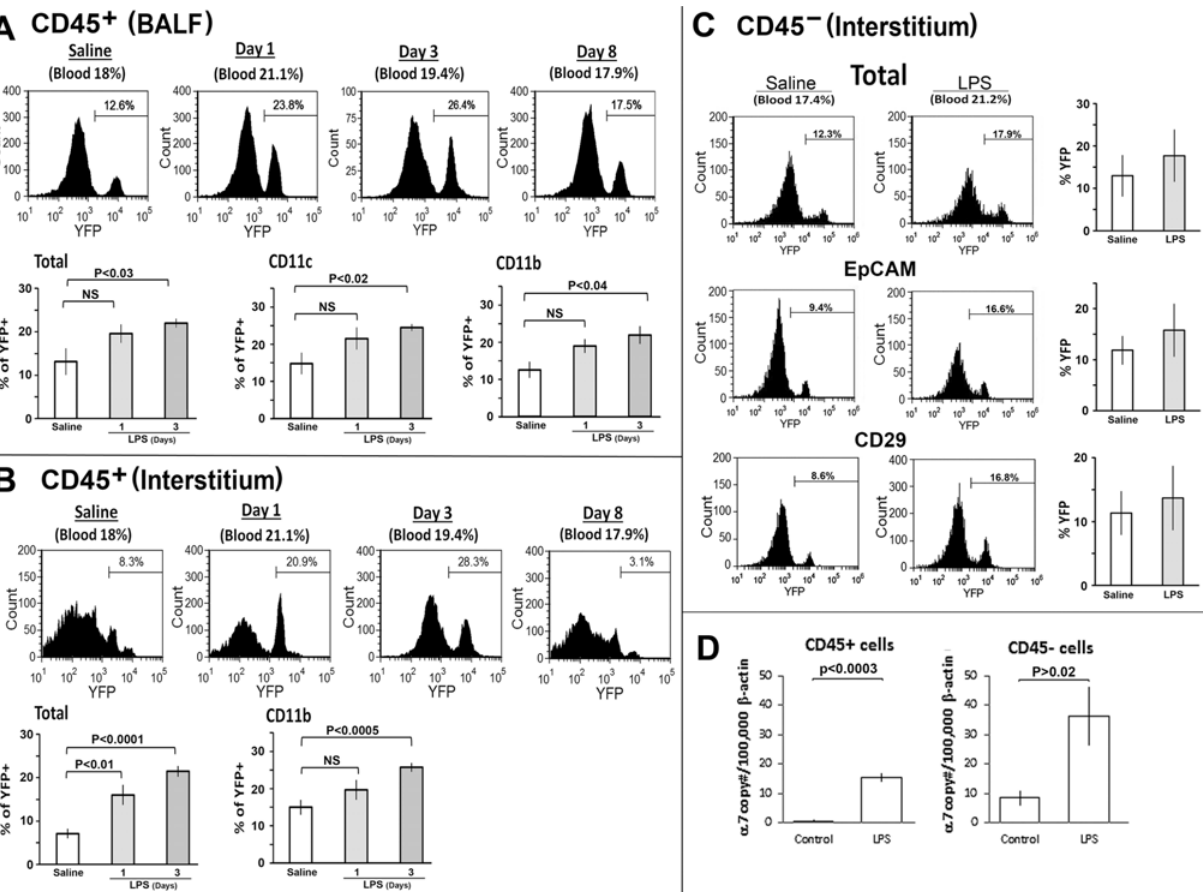
Fig 2. Phenotypic characteristics of BALF and interstitial cells from α 7 Cre:YFP mice challenged with i.n. LPS. Mice expressing cells that are lineage marked for WT α 7 expression ( α 7 Cre:YFP , 3 – 5 mo, 3 – 5 mice per group) were challenged with i.n. LPS (250 μ g/mouse in 30 μ l of saline). Control mice received i.n. 30 μ l of saline. With LPS administration i.n., the number of cells isolated from the BALF and interstitium (CD45 + ) increases 2 to 3 fold by 72 hrs. A minimum of twenty thousand events were collected for each sample. Histograms reflect the percent of α 7 lin+ (YFP + ) cells that are present on the days noted. The bar graphs represent data combined from three independent experiments (3 – 5 mice per experimental group in these experiments) with error bars reflecting plus-minus the standard error of the mean. Significance levels were determined using the Student ’ s t-test and this reflects the summed results of from at least three independent experiments. (A) BALF cells were isolated, FcR γ -blocked and stained with anti-mouse CD45, CD11c, and CD11b antibodies. In these experiments BALF was collected at Days 1, 3 and 8 for comparison to the na ï ve (saline control) group. Quantitative results are shown for day 1 and 3, where day 3 was observed to be the optimal response to LPS. Note the selective increase in the α 7 lin+ (YFP + ) cell percentage after LPS exposure. (B, C) Cells of the interstitium were isolated from the remaining lung tissues by enzymatic digestion and stained with anti-mouse CD45, CD11b, EpCAM, and CD29. Flow cytometric gating was on either CD45 + cells (B) or on CD45 - cells (C). The increase in percentage of CD45 - α 7 lin+ (YFP + ) cell after LPS exposure in this time frame was less in comparison to the CD45 + population. (D) Interstitial lung CD45 + and CD45 - cells were collected 72 hrs post-challenge with either i.n. saline or LPS using CD45 microbeads and autoMacs sorting. RNA was isolated from these populations (CD45 + or CD45 - ). In both populations an increase in α 7 RNA was observed in response to LPS administration. Combined analysis of α 7 gene transcripts from three independent experiments is shown. Data are presented as mean ± SEM.